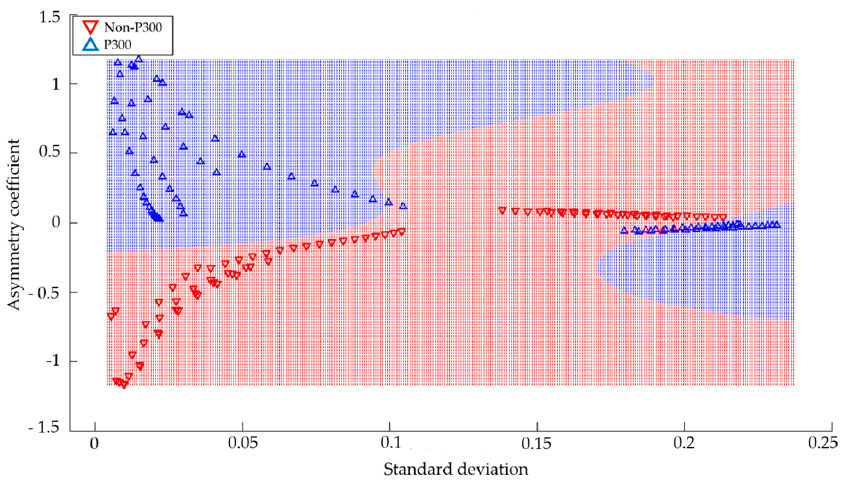
Figure 7. Classification obtained from Subject 3 with the SVM algorithm using the RBF kernel.